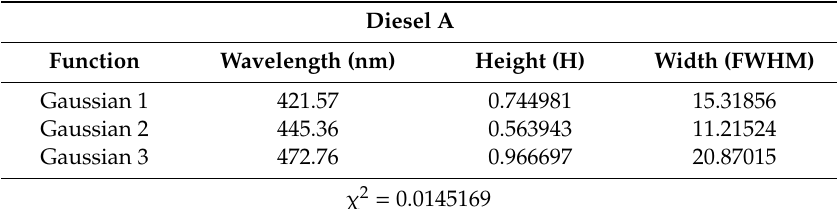
Table 1. Adjustment results with Gaussians of the diesel A spectrum after five iterations.